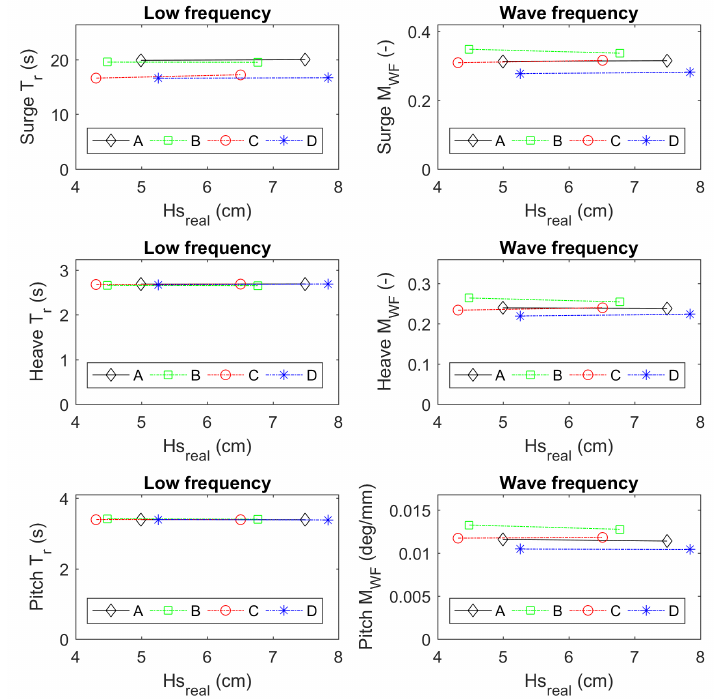
Figure 18. Metrics T r (left column) and M WF (right column) applied to surge (top row), heave (middle row), and pitch (bottom row) motions for realised significant wave height ( H s JONSWAP T p = 1.29 s, H s = 5 cm, and 7.5cm sea-states per